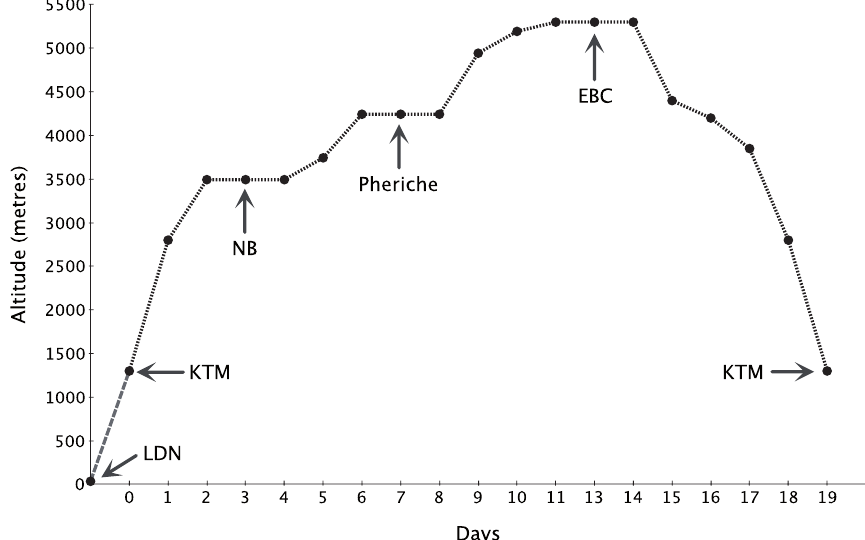
Figure 1. Ascent and descent profile for XE2 Everest Base Camp trek. Key: LDN = London, KTM = Kathmandu, NB = Namche Bazaar, EBC = Everest Base